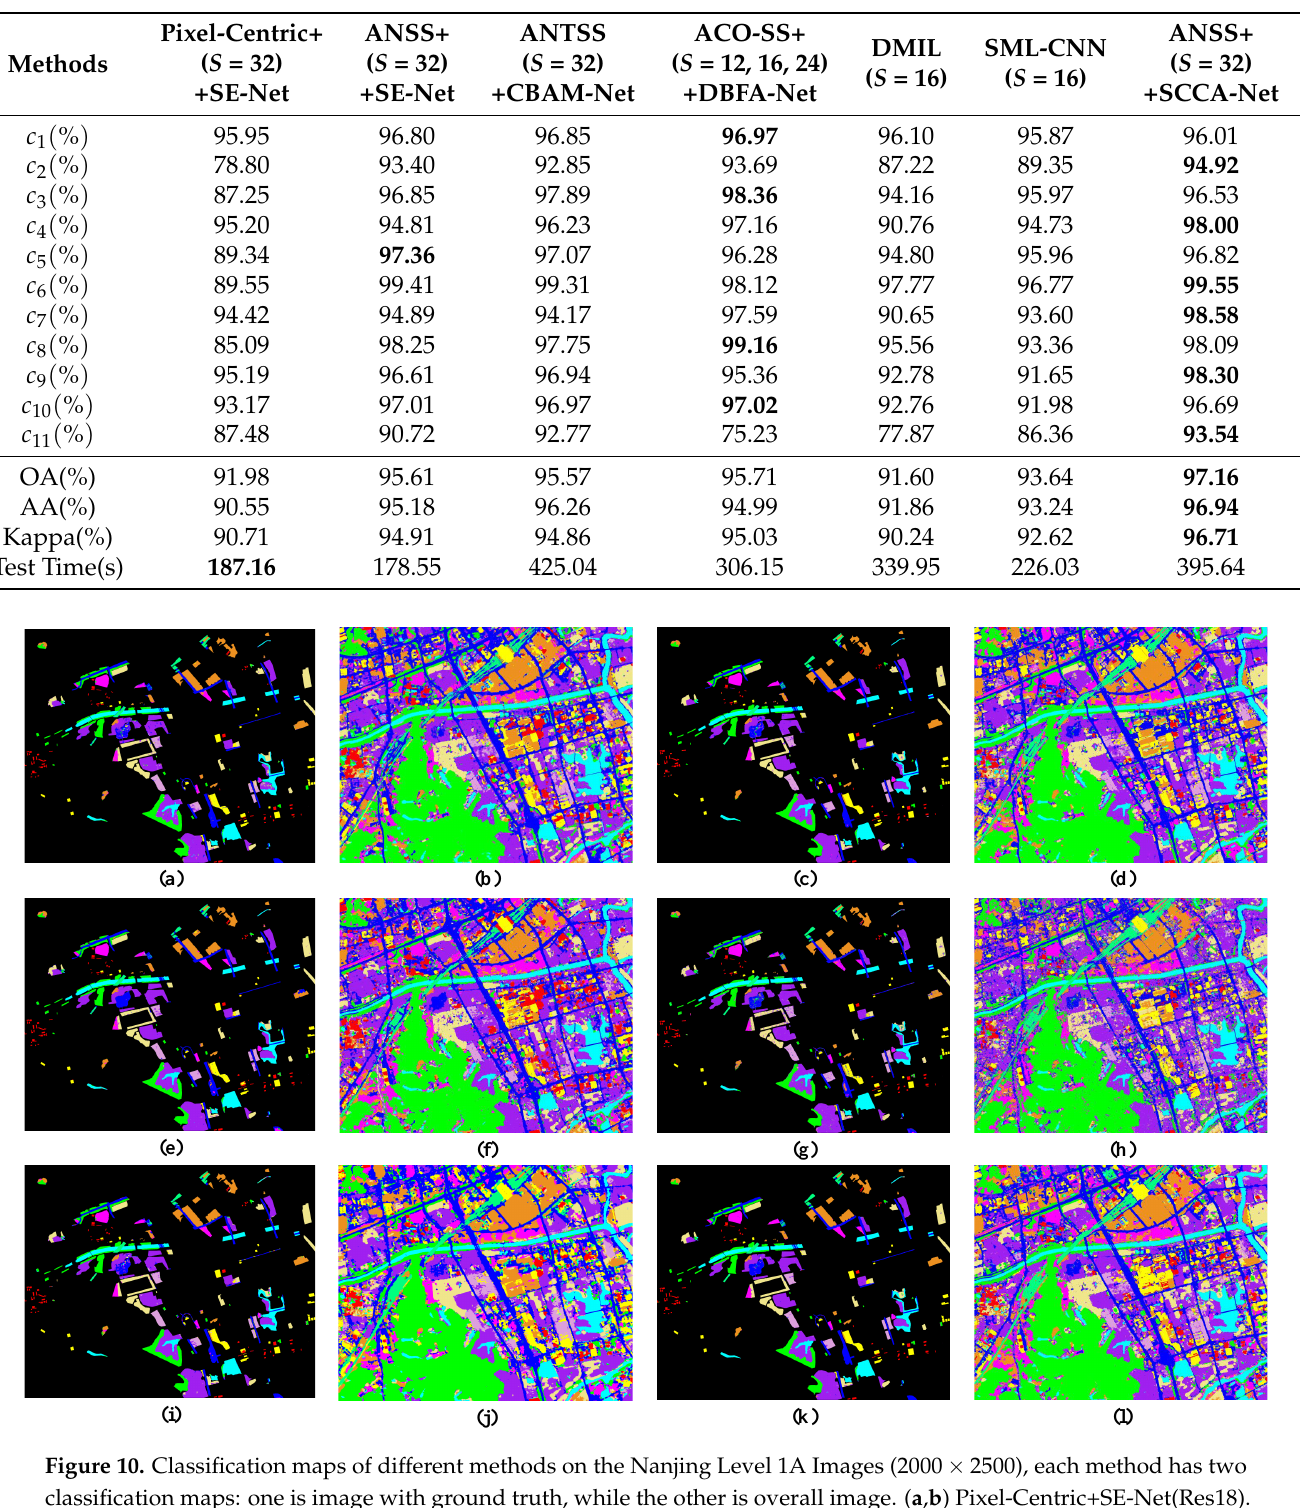
Table 6. Quantitative Classification Results of Nanjing Level 1A Images.